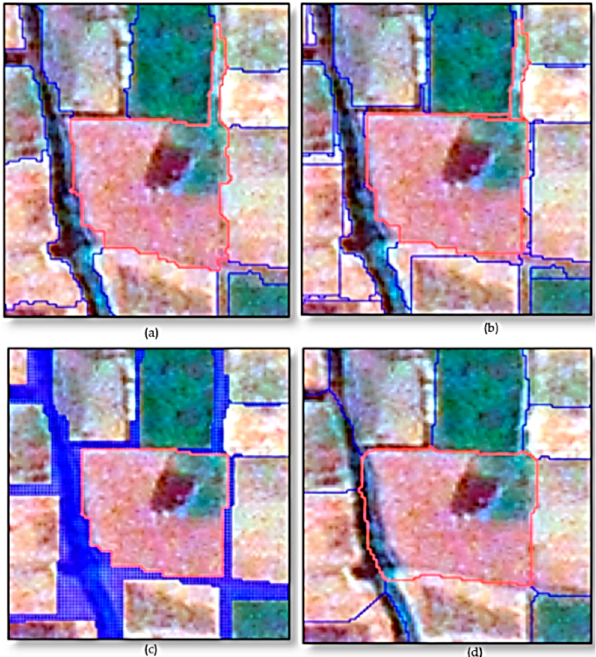
Figure 8. Boundary enhancement: ( a ) boundaries before enhancement; ( b ) dangling areas are trimmed off; ( c ) dangling features are split into smaller chunks and ( d ) parcels are dilated to include nearby dangling chunks.